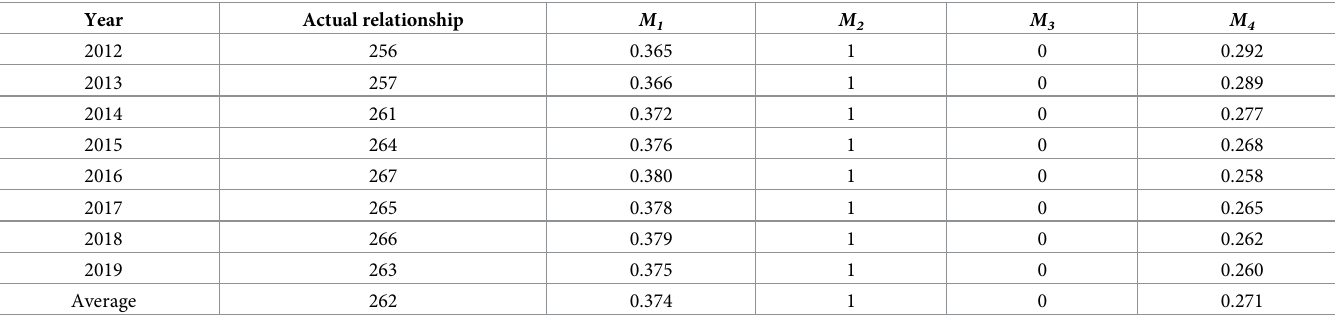
Table 2. Overall characteristics of the spatio-temporal network in the